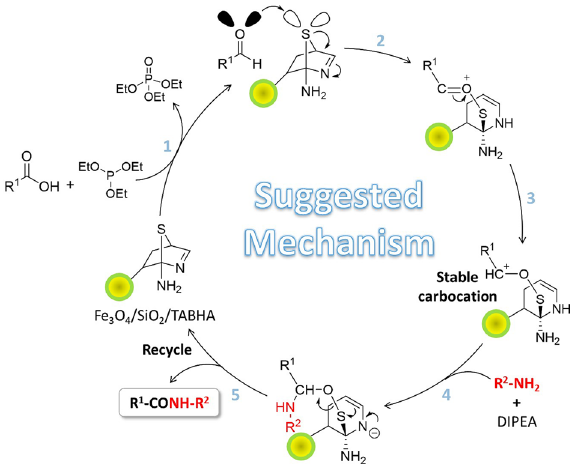
Figure 9. A plausible multi-stage mechanism for the synthesis of the dipeptides by the fabricated Fe 3 O 4 @SiO 2 / TABHA catalytic